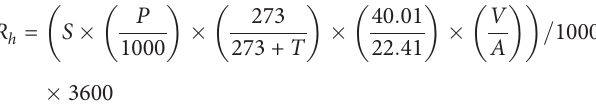
TABLE 1 | Range in day time and night time results for soil and air temperatures and fl ux, from raised beds and trenches. Microtopography Diurnal (n measurements) Soil temperature (°C, mean ± SD,